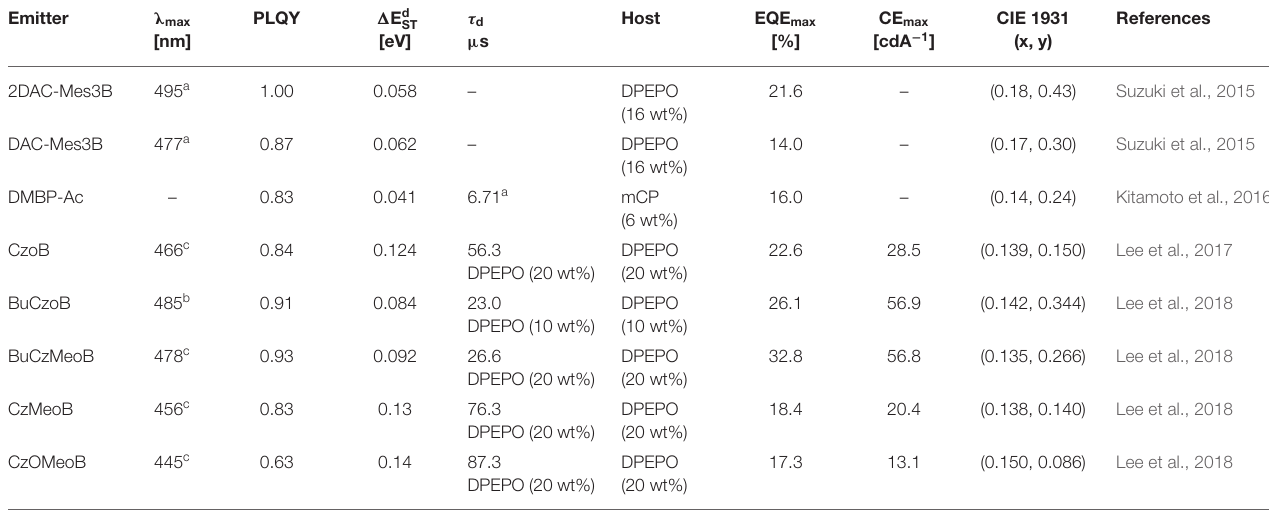
TABLE 1 | Summary of photophysical properties and device performance of the unbridged boron-type acceptor for blue thermally activated delayed fluorescence (TADF)